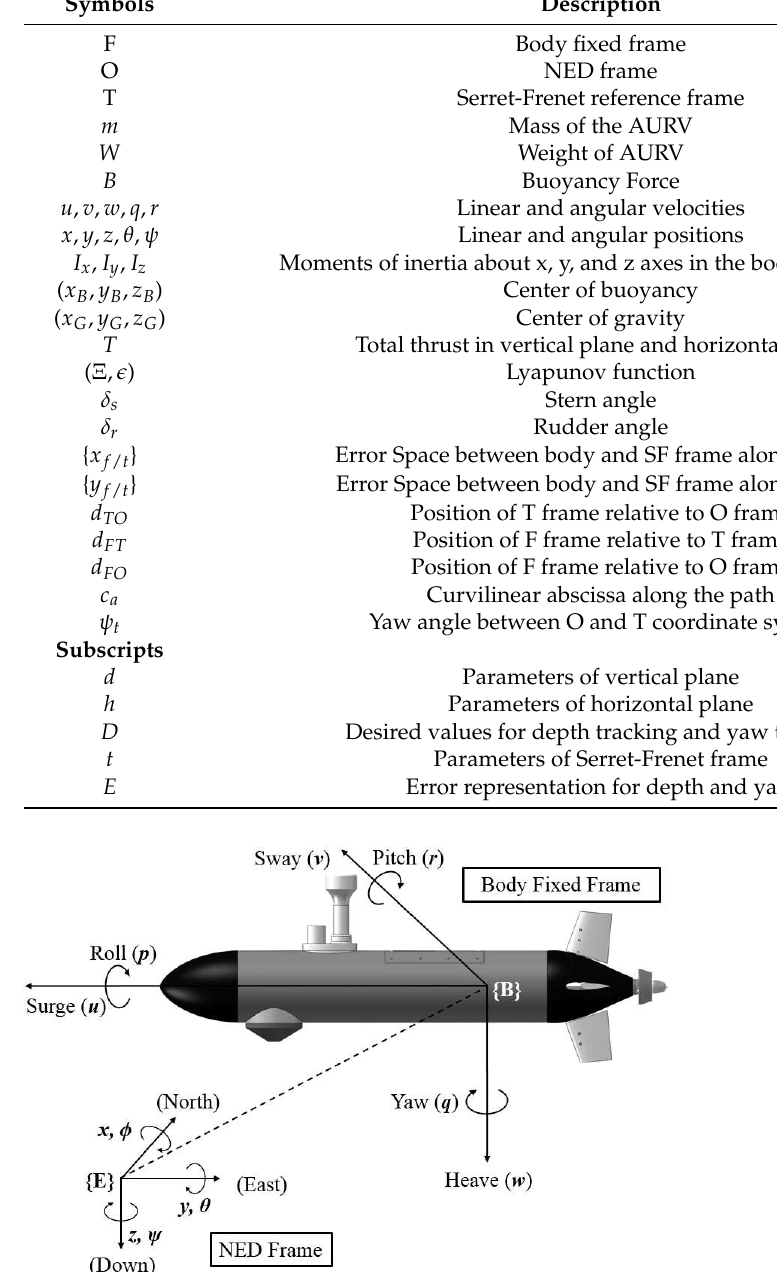
Figure 1. Structure of AURV based on Reference